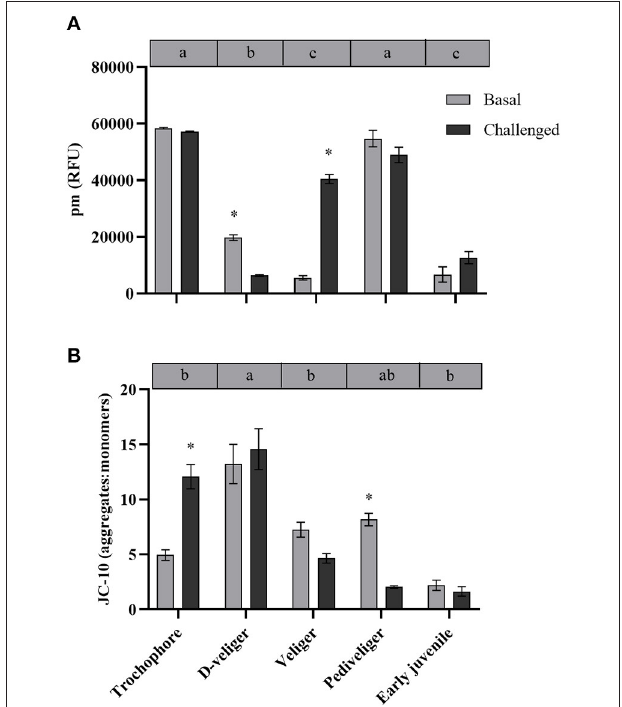
FIGURE 2 | (A) Mitochondrial density ( ρ m) and (B) mitochondrial membrane potential ( 19 m) throughout larval developmental stages and in early juveniles from the scallop Argopecten purpuratus. Here, ρ m is expressed as relative fluorescence units (RFU) while 19 m is expressed as a JC-10 fluorescence intensity ratio (aggregate/red: monomer/green). Different lowercase letters inside bars at the top of each graph indicate significant differences among developmental stages in basal conditions ( P < 0.05). Asterisks indicate significant differences between control and challenged groups ( P < 0.05). n = 4 pools per